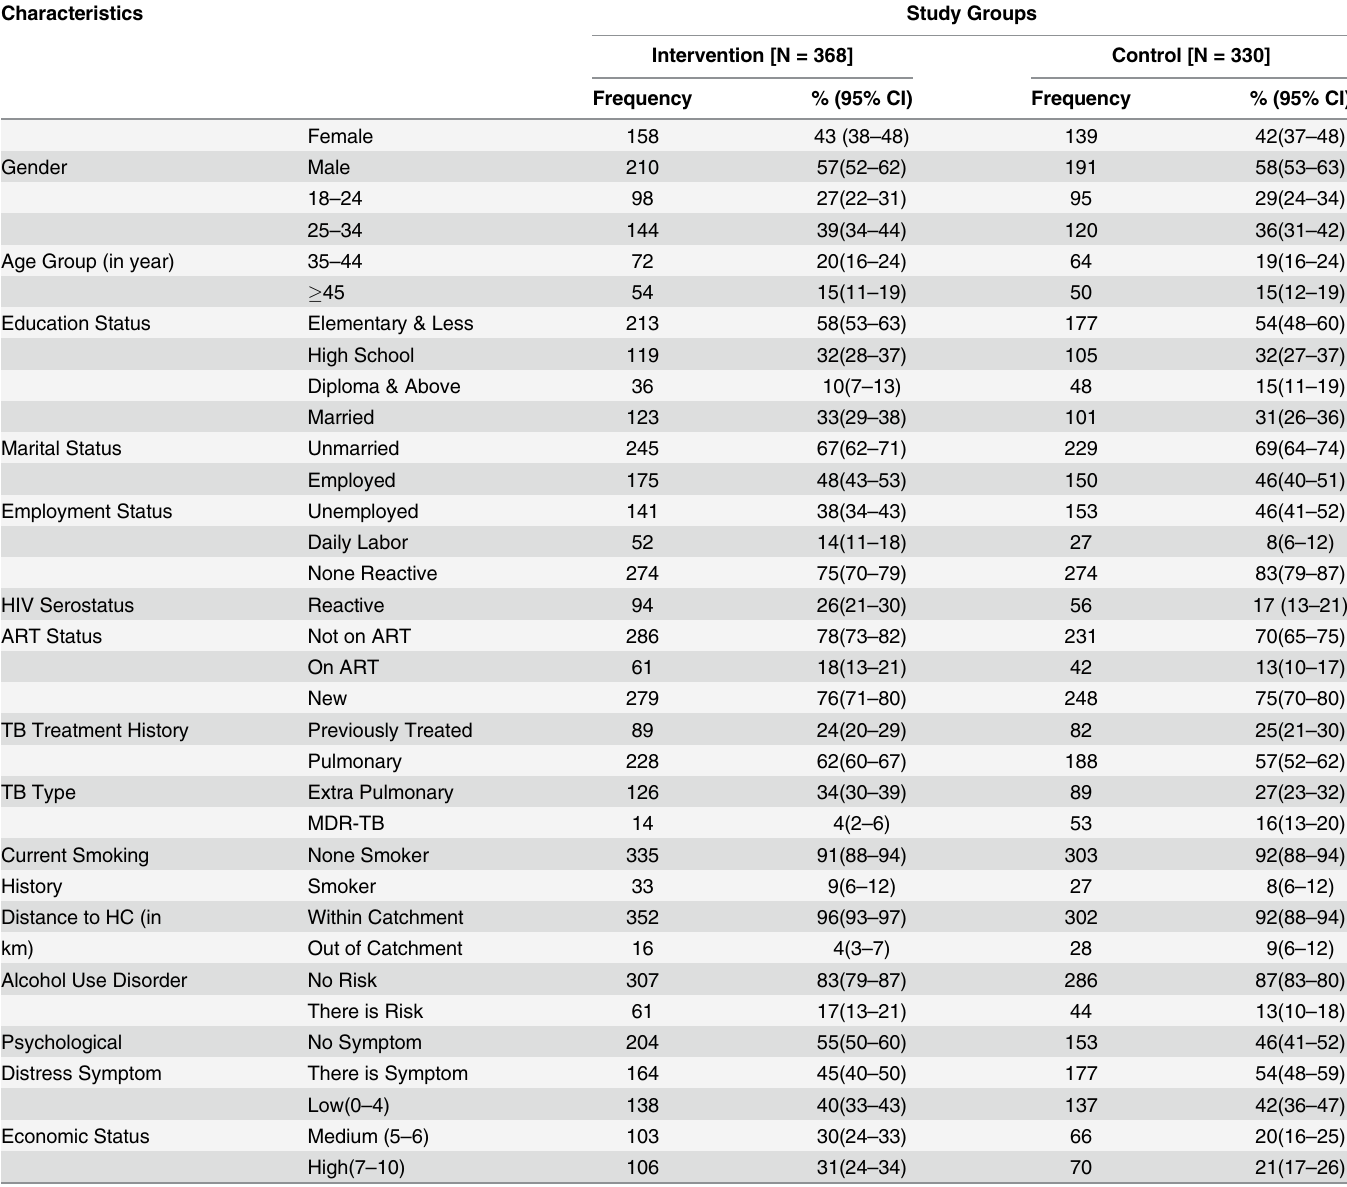
Table 1. Baseline Participants ’